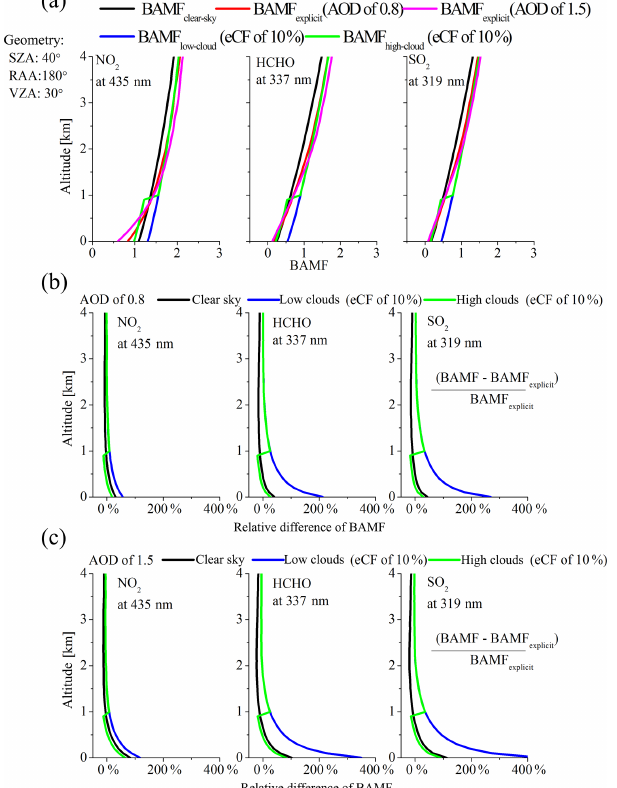
Figure 16. (a) Simulated BAMF clear − sky , BAMF explicit for AOD of 0.8 and 1.5, BAMF low − cloud (cloud at surface) and BAMF high − cloud (cloud at 1km) of NO 2 at 435nm, HCHO at 337nm and SO 2 at 319nm for one typical satellite observation (SZA of 40 ◦ , RAA of 180 ◦ and VZA of 30 ◦ ). An effective cloud fraction of 10% is used in the calculations. (b) Relative differ- ences of BAMF clear − sky , BAMF lowclouds and BAMF high − clouds compared to BAMF explicit for AOD of 0.8. (c) Same as (b) but BAMF explicit for AOD of 1.5.